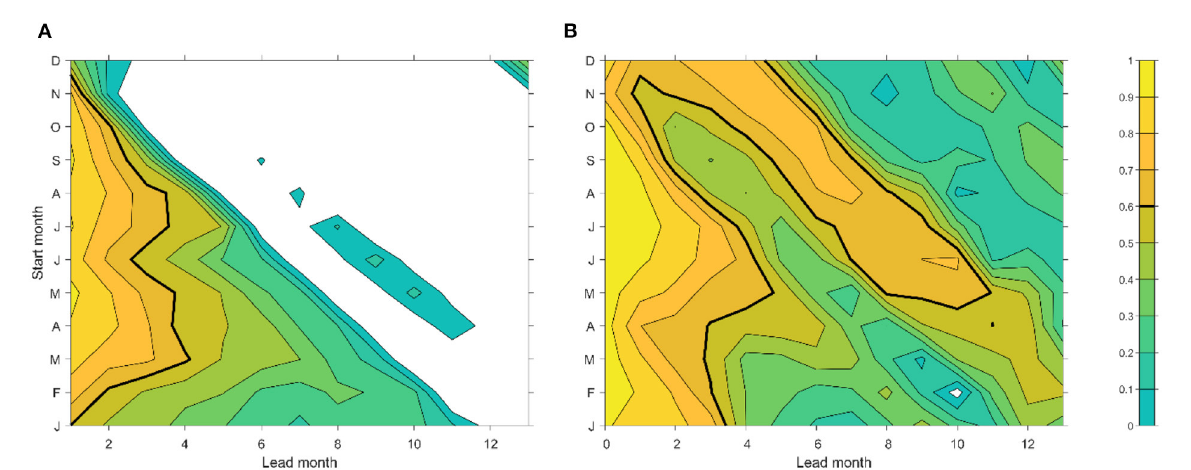
FIGURE2 (A) Persistence of eastern IOD SST anomalies and (B) correlation prediction skills of the CNN model starting from each calendar month. Negative skills are not plotted and skills of 0.6 are denoted by bold contour lines. Persistence skills are calculated using GODAS data during the 1982–2020 period. In (B) , the 1-month lead refers to the CNN model run using January to March input to predict April EIOD SST